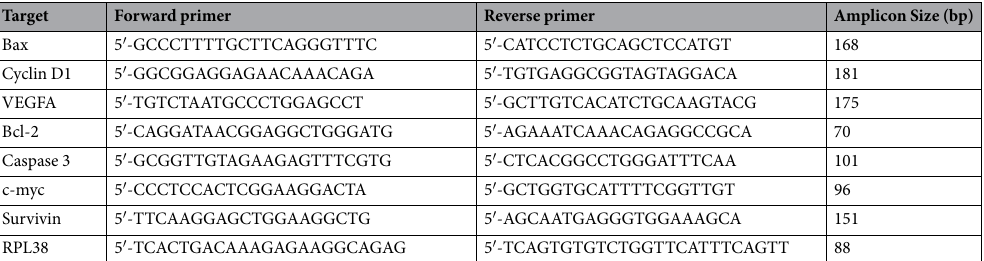
Table 2. Primers used in quantitative PCR and the amplicon sizes (bp: base